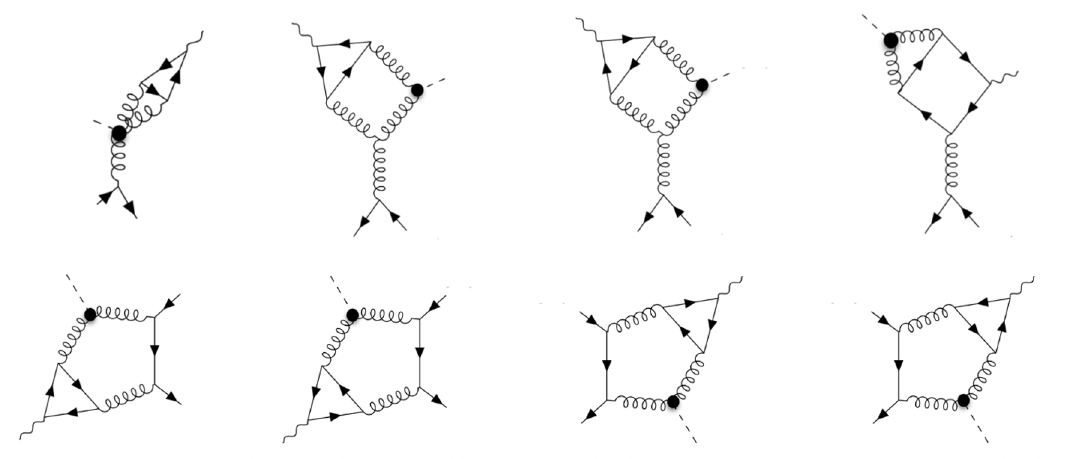
Figure 11 . The two-loop diagrams proportional to (cid:21) t for q (cid:22) q ! ZH with an open massless quark line q and a quark loop in HEFT. The (cid:12)rst four diagrams vanish because of color